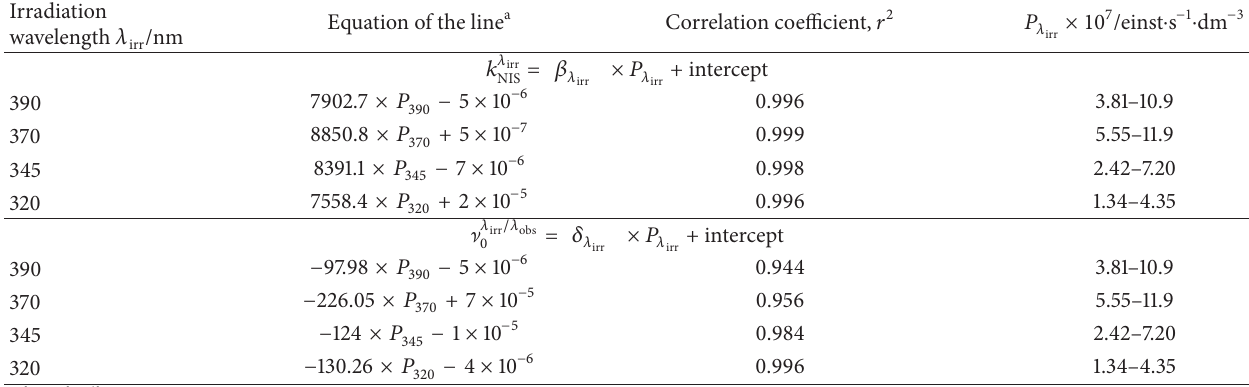
) and initial reaction velocities ( ] 𝜆 irr /𝜆 obs NIS